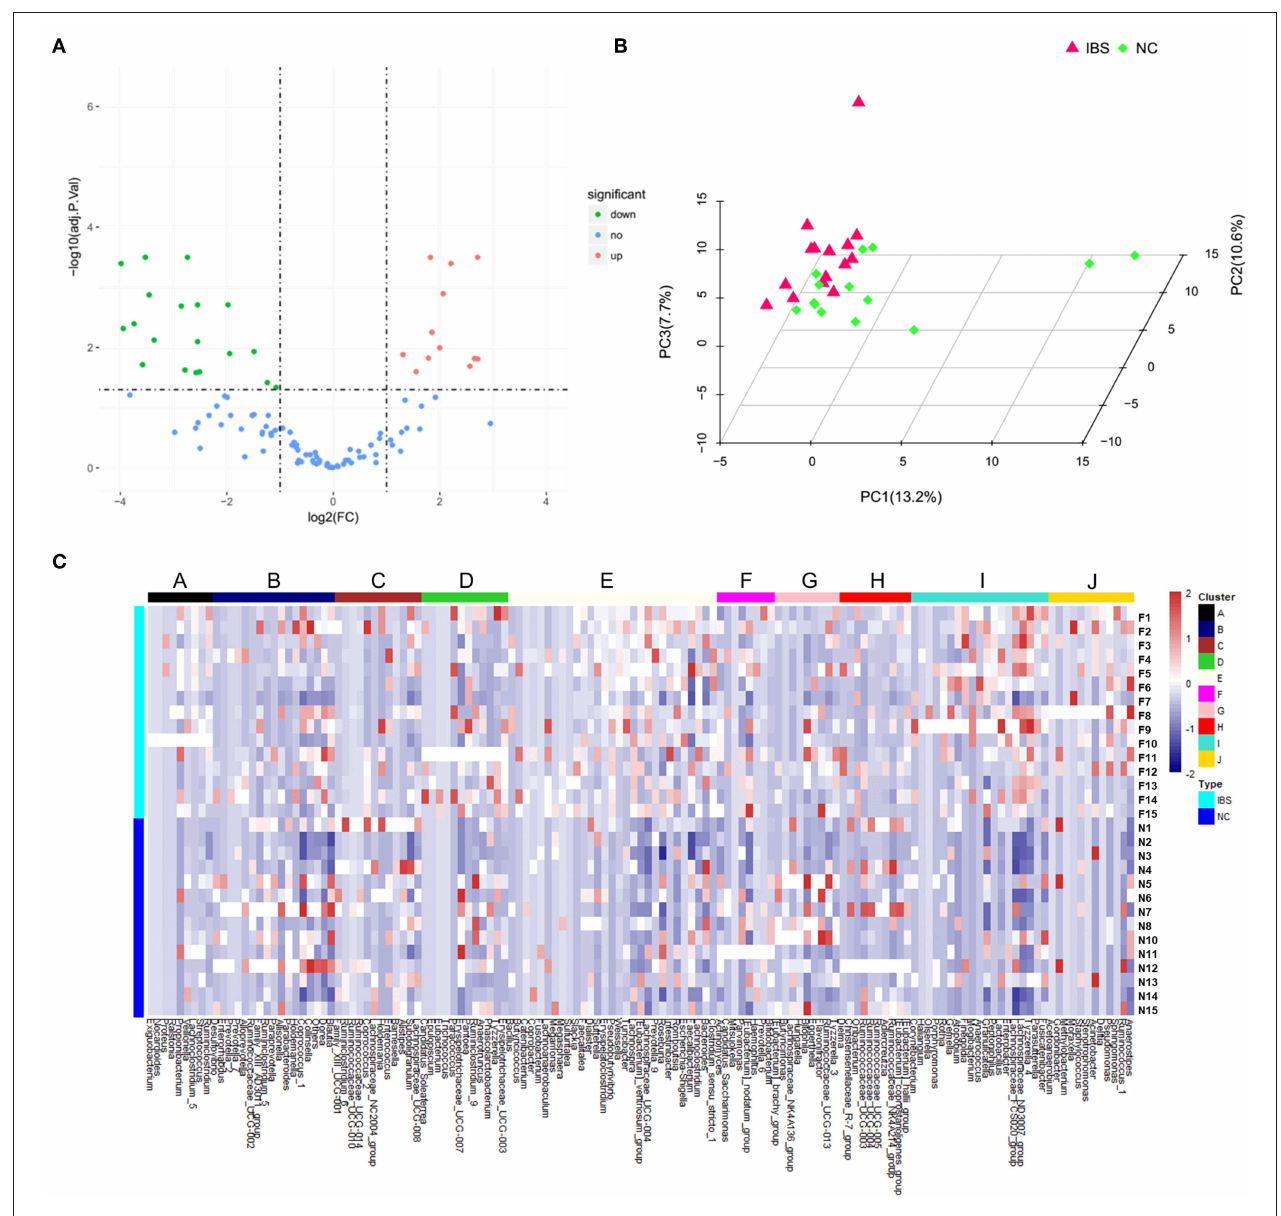
FIGURE 2 | Microbial profiling analysis in IBS and healthy controls. (A) Volcano Plots showed that there were 19 significantly up-regulated (red dots) and 12 markedly down-regulated (green dots) microbial populations in IBS patients compared to the healthy controls. (B) PCA plots showed the IBS patients couldn’t be discriminated from the healthy controls. (C) The heatmap profile showed that all microbes detected were divided into 10 clusters, and no single genus or genus cluster could clearly identify IBS from the healthy